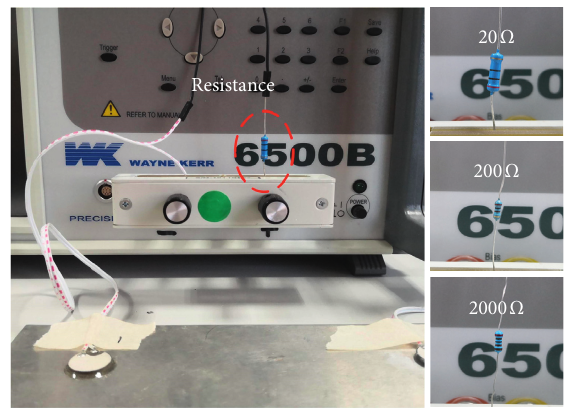
Figure 4: Pseudosoldering of 1# PZT including mild pseudosoldering (20 Ω ), moderate pseudosoldering (200 Ω ), and severe pseudo- soldering (2000 Ω ).